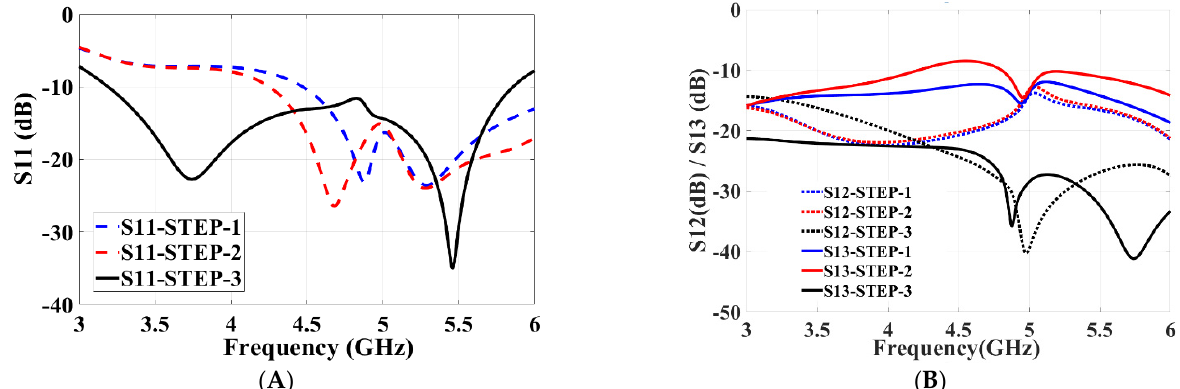
Figure 4. Design evolution of the ground plane structure for the proposed antenna.